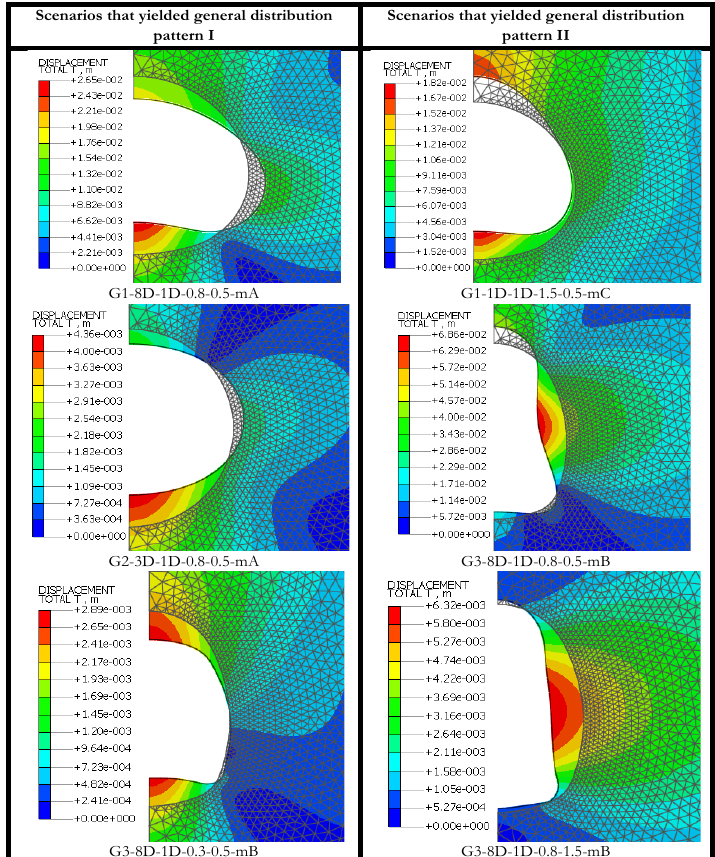
Figure 11. Variation of displacements in calculation stage (E3) in relation to normalized load general distribution